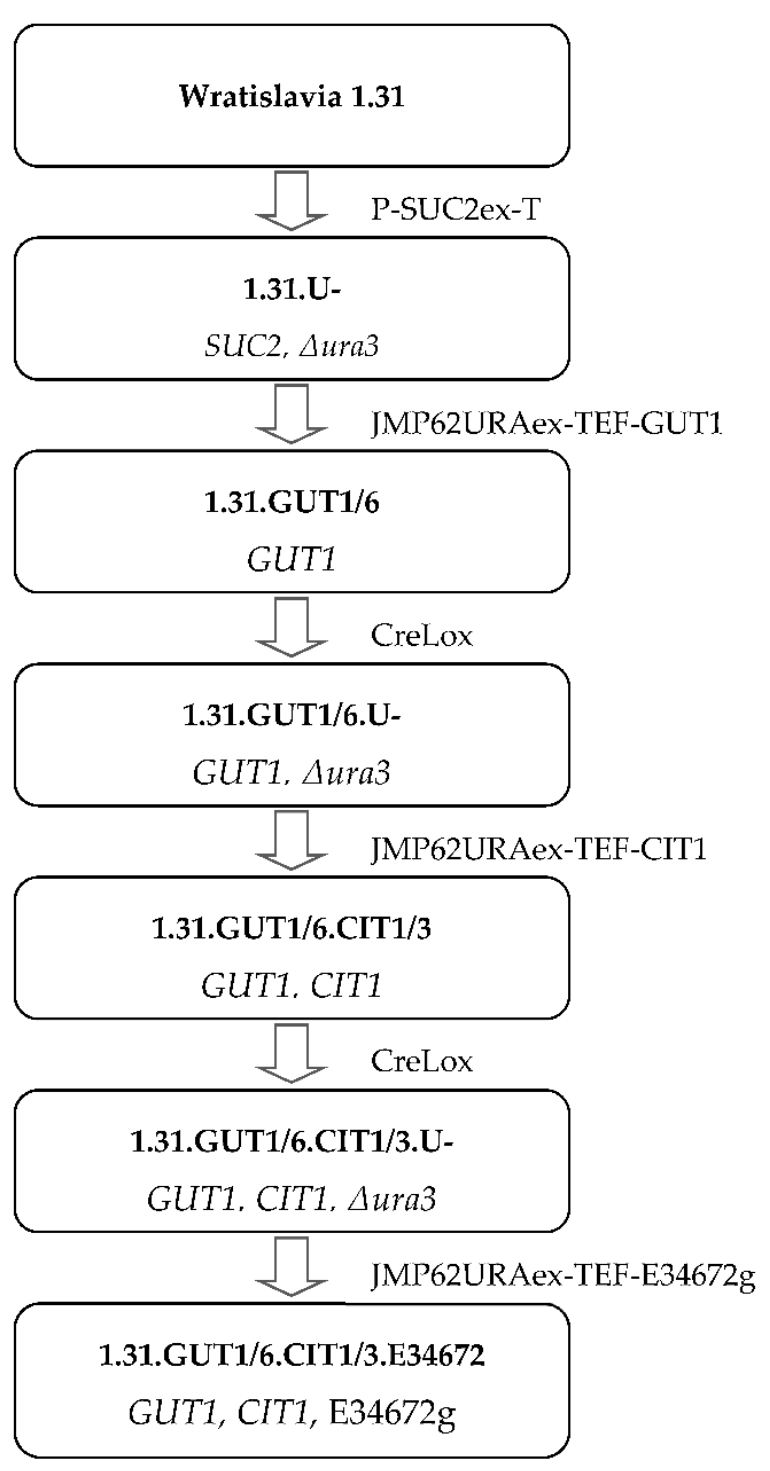
Figure 5. The schematic representation of obtaining transformants of Y. lipolytica Wratislavia